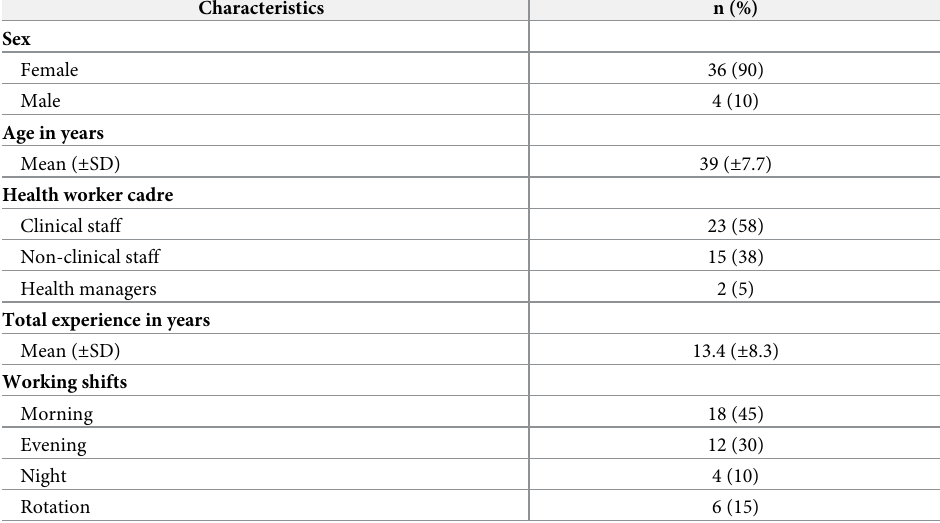
Table 1. Characteristics of study